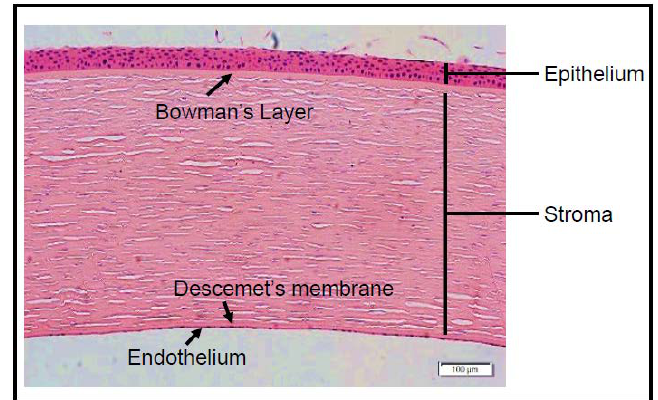
Figure 2. H&E image of a human cornea. A representative image of a human cornea. Corneal layers from anterior to posterior include epithelium, Bowman’s layer, stroma, Descemet’s membrane, and endothelium, respectively. The scale represents 100 µm in length.